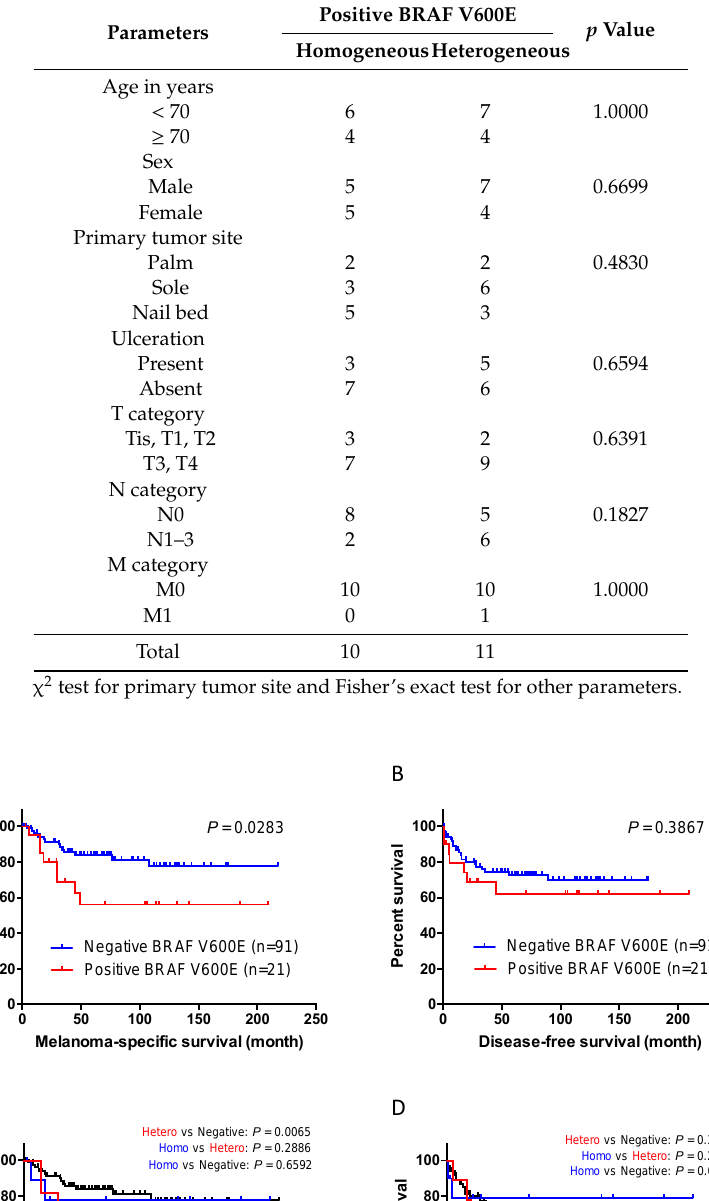
Table 3. Comparison with clinicopathological factors between heterogeneous and homogeneous acral melanoma.